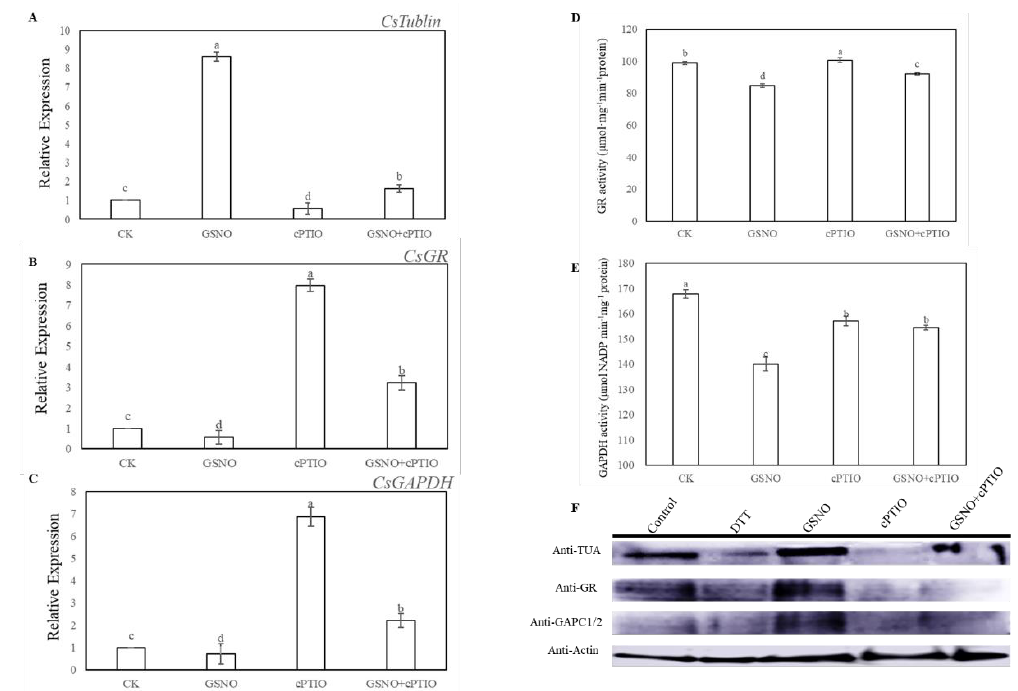
Figure 5. Effect of GSNO on the expression levels, enzymatic activities and S -nitrosylation level of tubulin alpha chain (TUA), glutathione reductase (GR), and glyceraldehyde-3-phosphate dehydrogenase (GAPDH) during adventitious rooting. Explants were incubated with distilled water (CK) or 200 μM cPTIO, 50 μM GSNO, or 50 μM GSNO + 200 μM cPTIO. TUA , GR and GAPDH expression level ( A, B, C ), and GR and GADPH activity ( D, E ) in cucumber explants was determined at 6 h of treatment. Immunoblot analysis of S -nitrosylated proteins in vivo ( F ). After biotinylation, proteins were purified with neutravidin-agarose, separated by sodium dodecyl sulfate-polyacrylamide gel (SDS-PAGE), and immunoblotted with anti-TUA, anti-GR, and anti-GAPDH antibodies. Bars with different lowercase letters were significantly different by Duncan’s multiple range test (p < 0.05). Bars with different lowercase letters were significantly different by Duncan’s multiple range test.